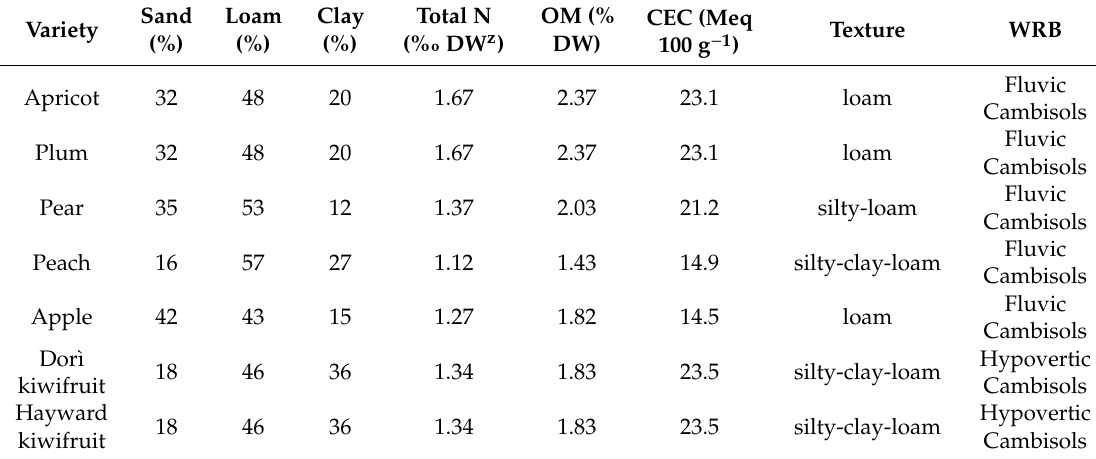
Table 2. Soil texture, total N, organic matter (OM), cation exchange capacity (CEC) and world reference base (WRB) soil classification of the orchards at planting. Variety